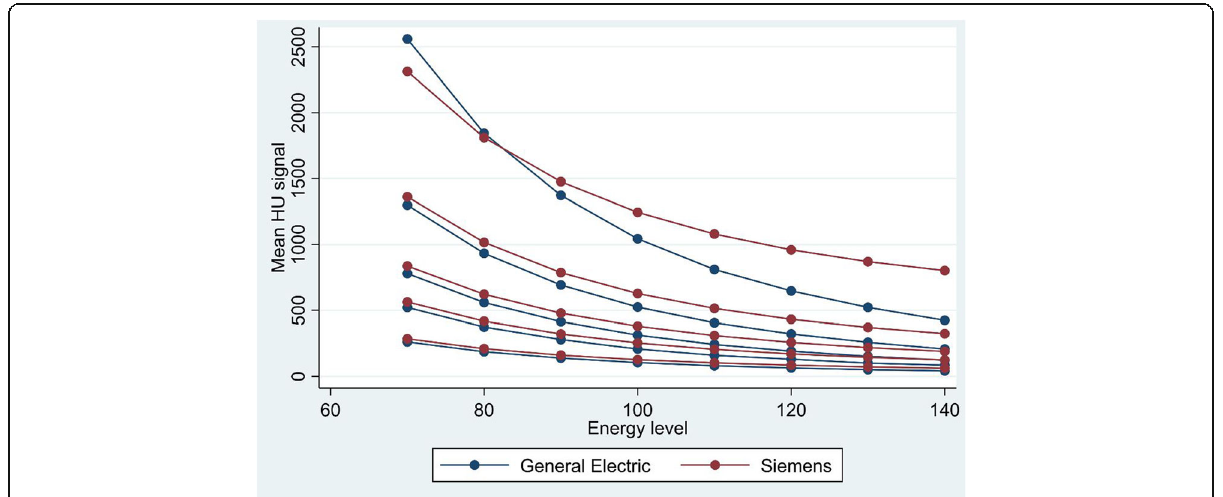
Fig. 2 The mean HU in reconstructed monoenergetic images for each concentration of iodine. The virtual monoenergetic energy levels have the unit keV. HU Hounsfield